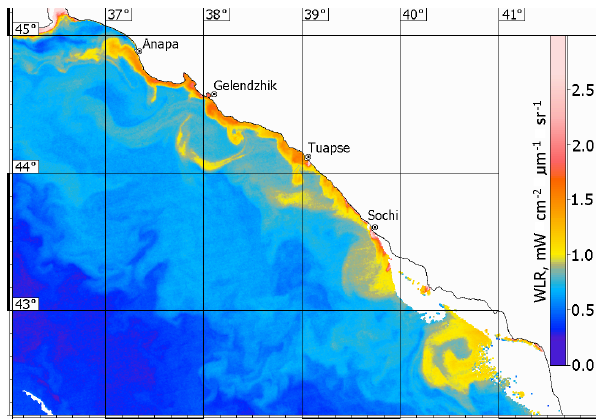
Figure 2. The Suomi NPP Visible Infrared Imaging Radiometer Suite image of the water leaving radiance (WLR) at a wavelength of 0.551mm over the NE Black Sea at 10:18GMT on 18 Febru- ary 2016 (data are courtesy of NASA at https://oceancolor.gsfc. nasa.gov/, last access: 9 November